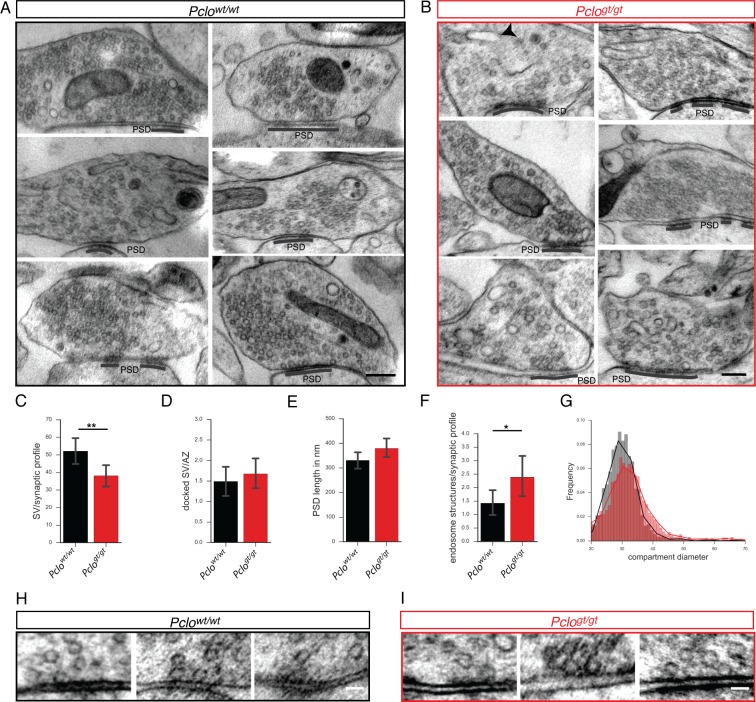
Pclogt/gt synapses display morphological changes at the ultrastructural level.(A and B) Example electron micrographs of Pclowt/wt (A) and Pclogt/gt (B) synapses. (C–G) Quantification of electron micrographs. (C) Synaptic vesicle density is decreased in Pclogt/gt terminals (Pclowt/wt = 51.73 ± 4.05, n = 52 synapses; Pclogt/gt = 38.08 ± 3.19, n = 59 synapses). (D) The number of docked vesicles per active zone is not altered (Pclowt/wt = 1.49 ± 0.18, n = 59 AZs; Pclogt/gt = 1.67 ± 0.18, n = 40 AZs). (E) The total length of the PSDs is not altered (Pclowt/wt = 331 ± 17.09 nm, n = 72 PSDs; Pclogt/gt = 379.6 ± 18.22 nm, n = 69 PSDs). (F) The number of endosome structures is increased at Pclogt/gt synapses (Pclowt/wt = 1.42 ± 0.24, n = 52 synapses; Pclogt/gt = 2.39 ± 0.38, n = 57 synapses). (G) Histogram depicting the distribution of endosome compartment diameters. Pclogt/gt vesicular compartments show a shift towards larger diameters (Pclowt/wt: n = 2729 compartments measured; Pclogt/gt: n = 2387 compartments measured). (H and I) Example electron micrographs showing docked vesicles at Pclowt/wt (H) and Pclogt/gt AZs (I). Scale bar in A and B 200 nm, scale bar in D and E 50 nm. Error bars in bar graph represent 95% confidence intervals. Numbers given represent mean ± SEM, Students t-test. * denotes p<0.05, ** denotes p<0.01.10.7554/eLife.46629.006Figure 2—source data 1.This spreadsheet contains the normalized values used to generate the bar plots shown in Figure 2C,D,E,F and G.